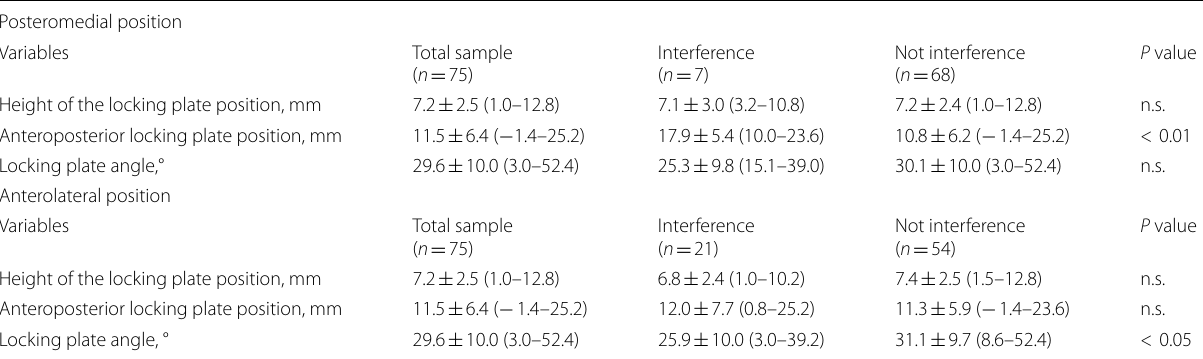
Data are presented as means